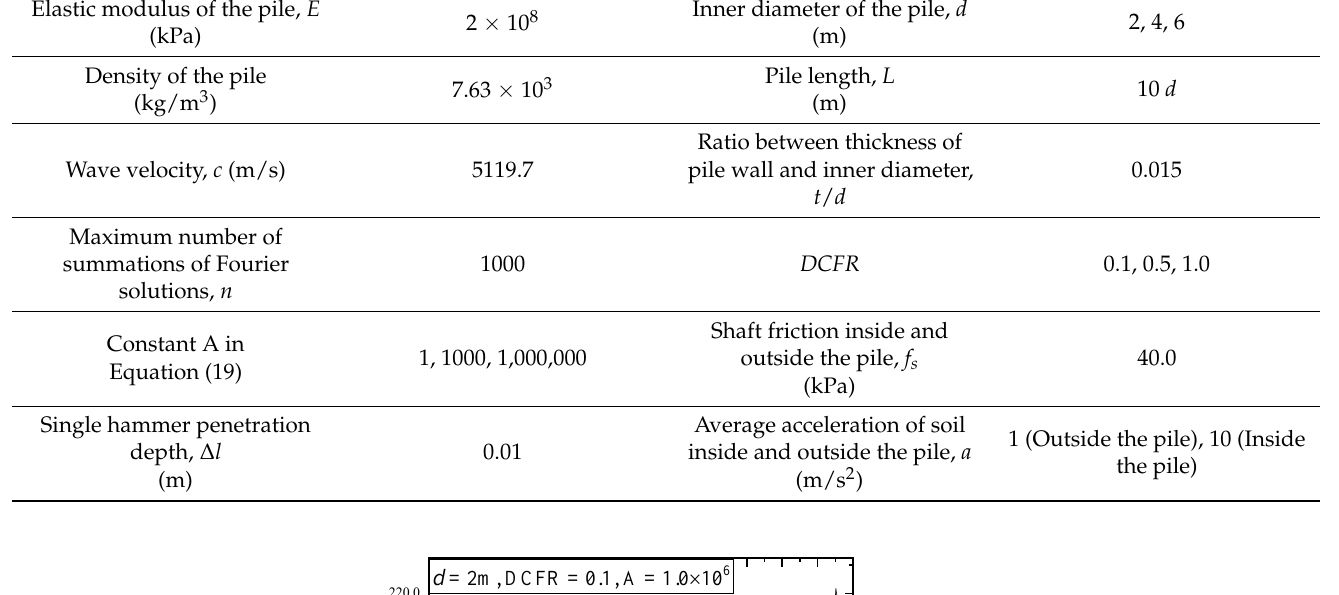
Table 1. Parameters of open-ended piles installed by impact loading.